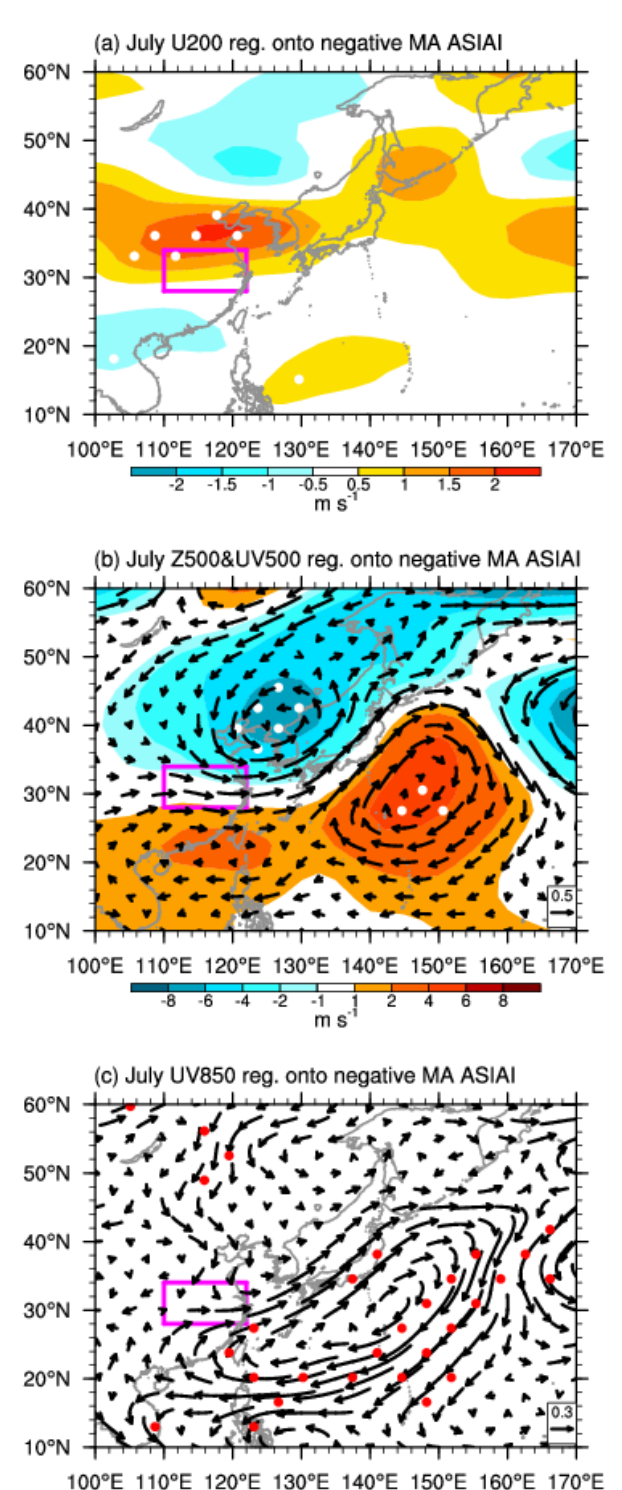
Figure 5. Regressed anomalies of July–mean ( a ) 200 hPa zonal wind (U200; shading; unit: m s − 1 ); ( b ) 500 hPa wind field (UV500; vectors; unit: m s − 1 ) and geopotential height (Z500; shading; unit: gpm); and ( c ) 850 hPa wind field (UV850; vectors; unit: m s − 1 ), with respect to the normalized negative MA–mean ASIAI.